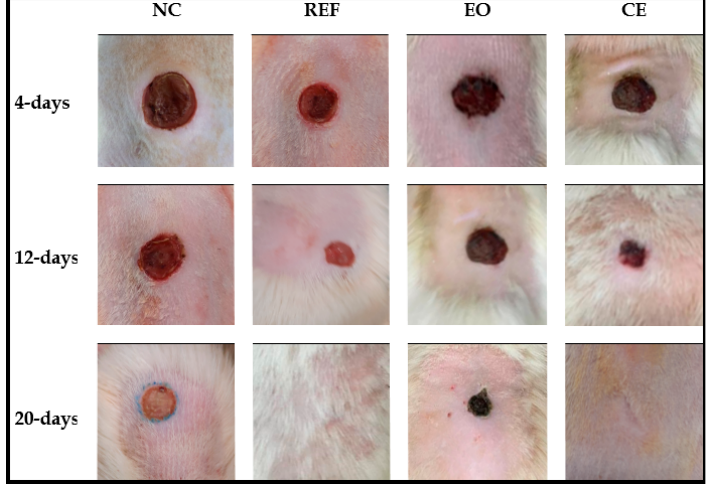
Figure 3. Photograph of wound area after topical application of Fucidin cream (REF) and essential oil (EO) and chloroform extract (CE) creams of Commiphora gileadensis in rats.